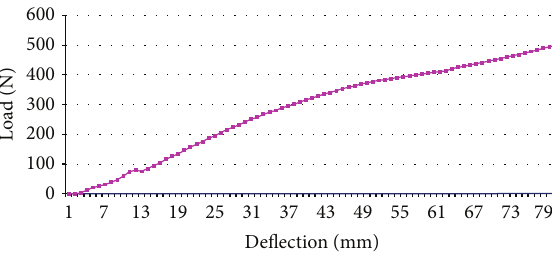
Figure 6: Graph of load deflection under